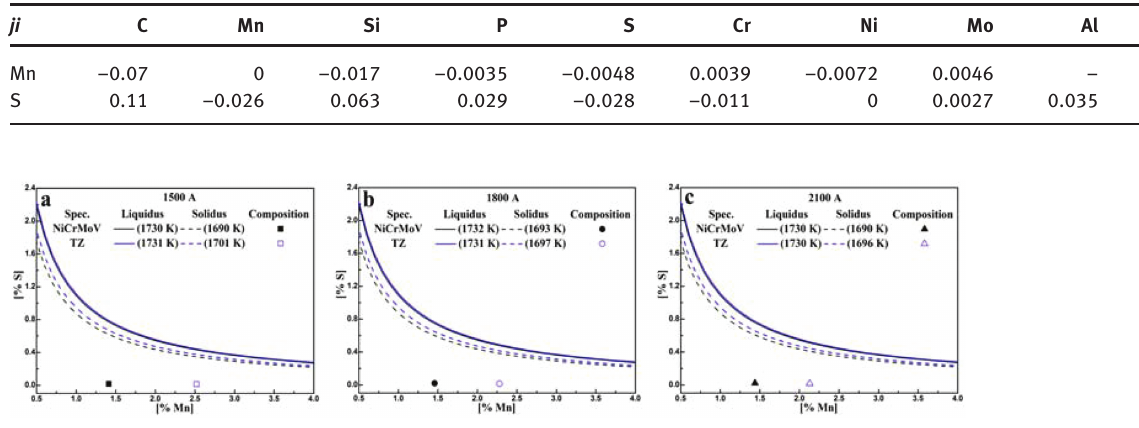
obtained from Figure 9, is 61.5 μ m, 49.6 μ m and 65.3 μ m,